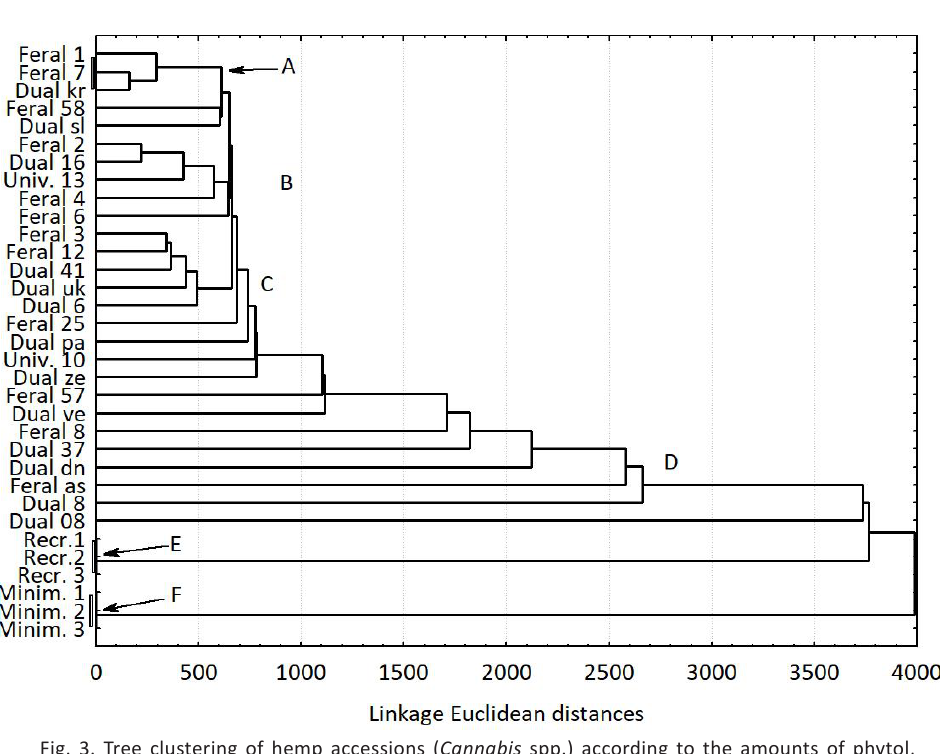
Fig. 3. Tree clustering of hemp accessions ( Cannabis spp.) according to the amounts of phytol, polyunsaturated fatty acids, polysaccharides and polyhydric alcohols in seeds. Accession designations along Y-axis: (Feral…) Feral; (Dual…) Dual-purpose (fiber and seed); (Univ. …) Universal (fibre, oil